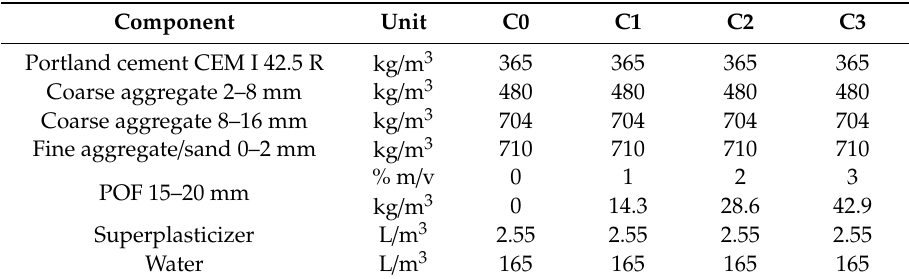
Table 1. Composition of concrete with polymer optical fibers (POFs) (kg / m 3